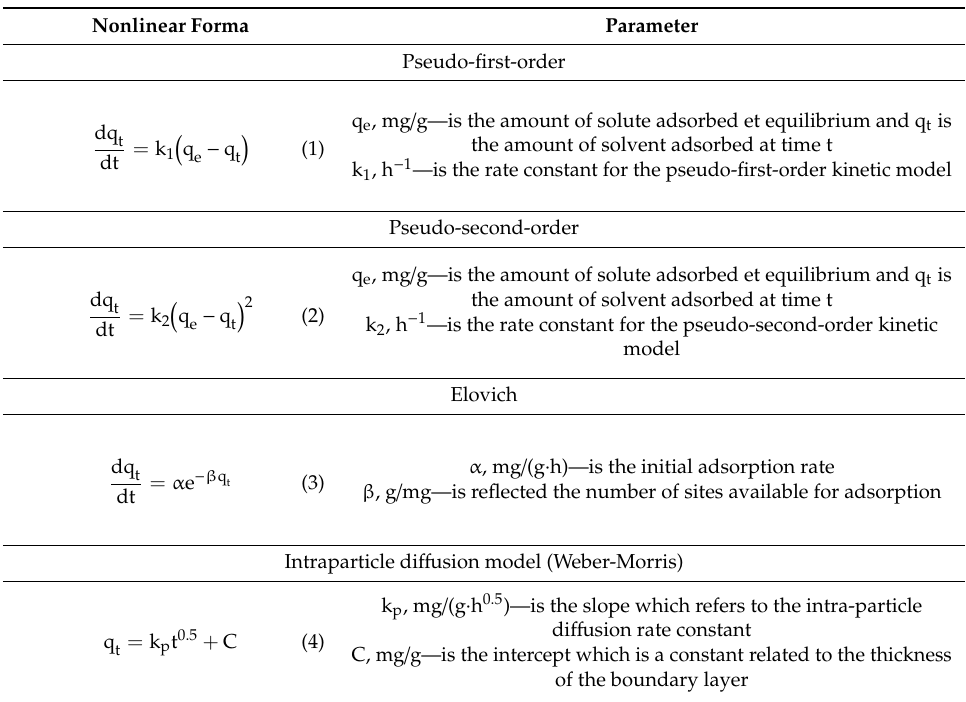
Table 2. Kinetic models’ equations [40,41].